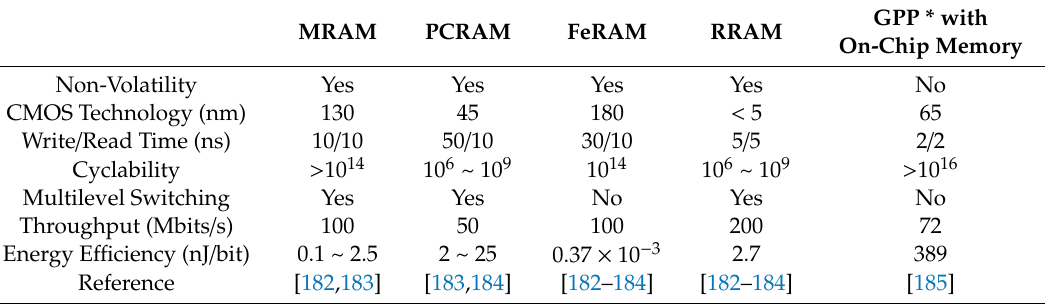
Table 1. Performance comparisons of di ff erent nonvolatile